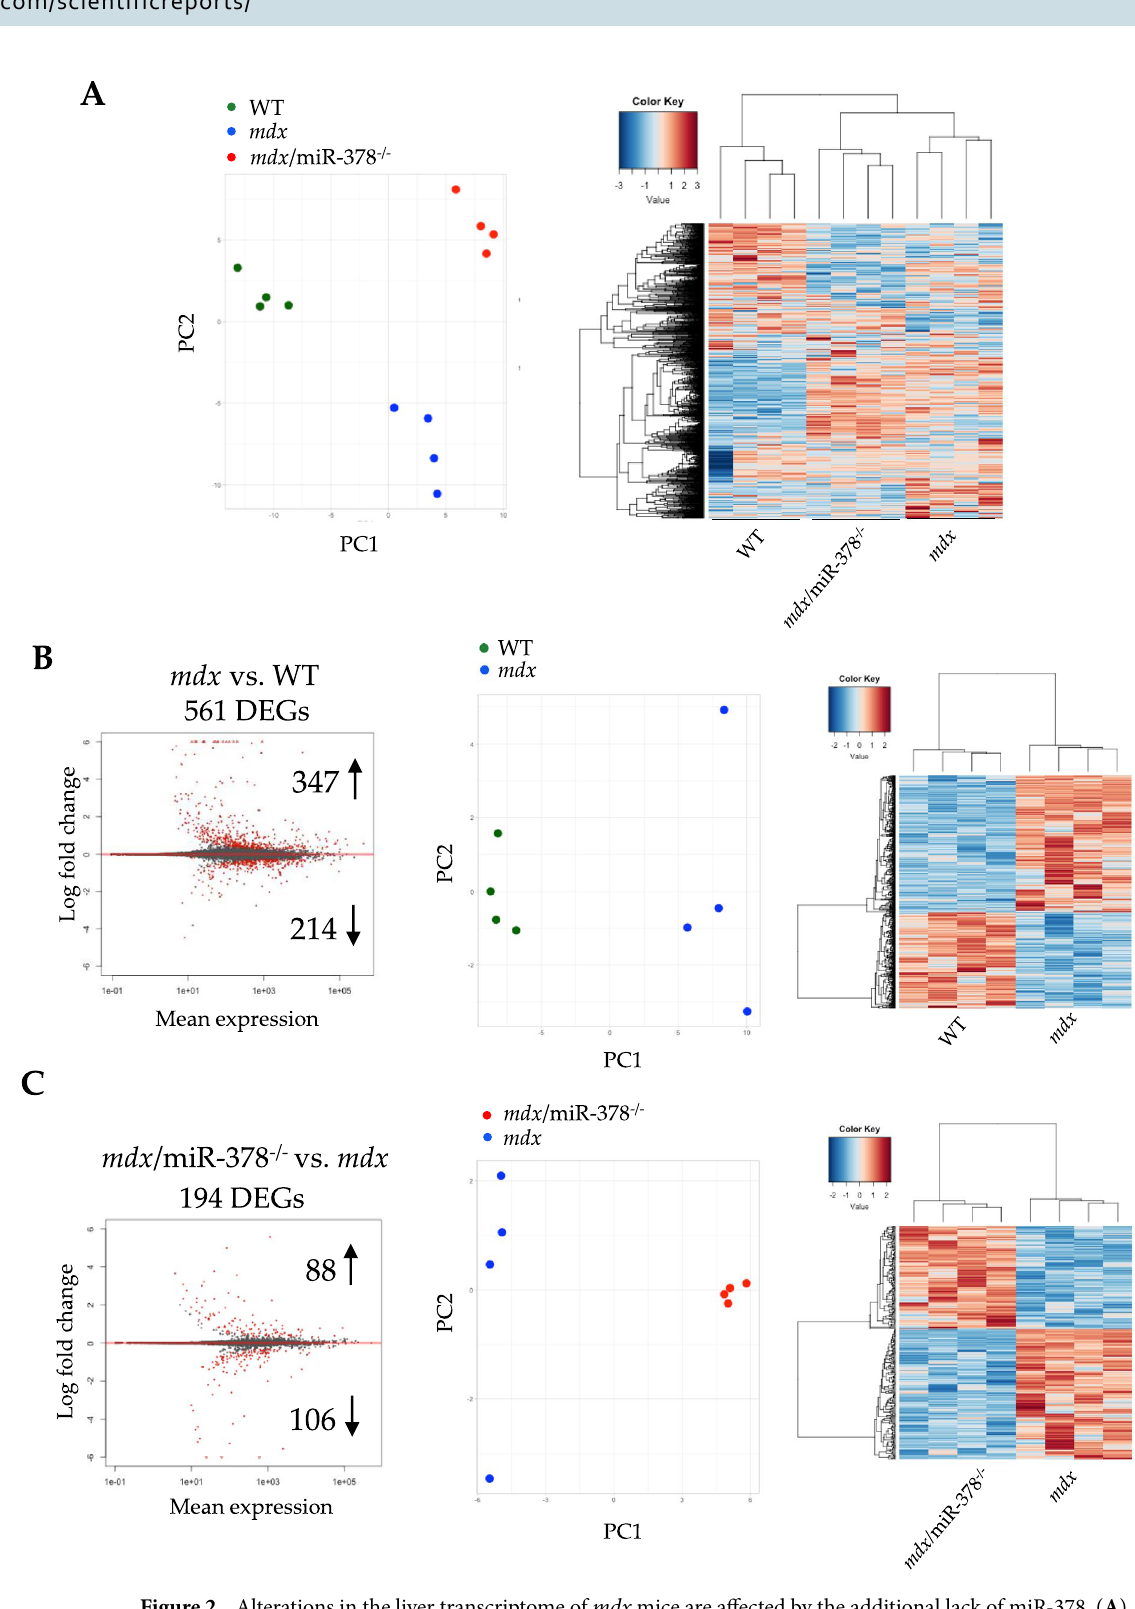
Figure 2. Alterations in the liver transcriptome of mdx mice are affected by the additional lack of miR-378. ( A ) Transcriptome profiling by RNA-seq in the mdx vs. WT mice and mice lacking both dystrophin and miR-378 ( mdx /miR-378 −/− ) vs. mdx segregates the investigated groups into 3 distinct clusters based on 1000 most variable genes, n = 4/group. ( B ) RNA-seq analysis revealed 561 DEGs between mdx vs. WT livers, and ( C ) 194 DEGs between mdx /miR-378 −/− vs. mdx that distinguish the analyzed groups by principal component analysis (PCA) and hierarchical